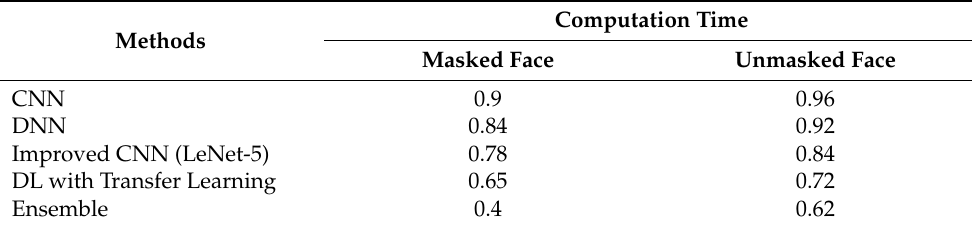
Table 7. Computation time